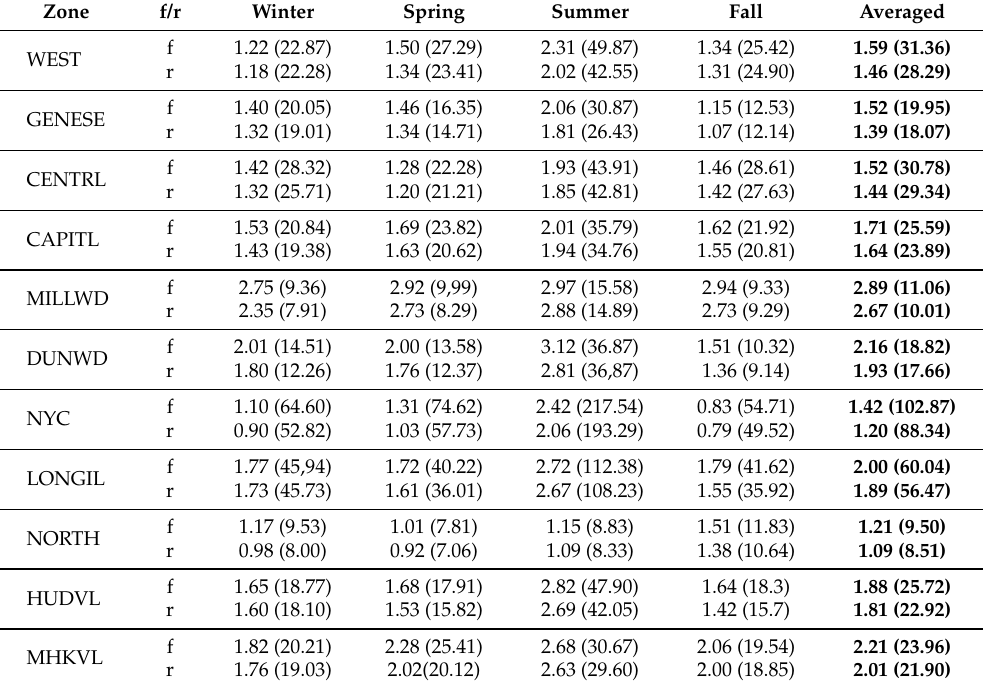
Table 4. MAPE (MAE) results for selected time intervals, for each NYISO